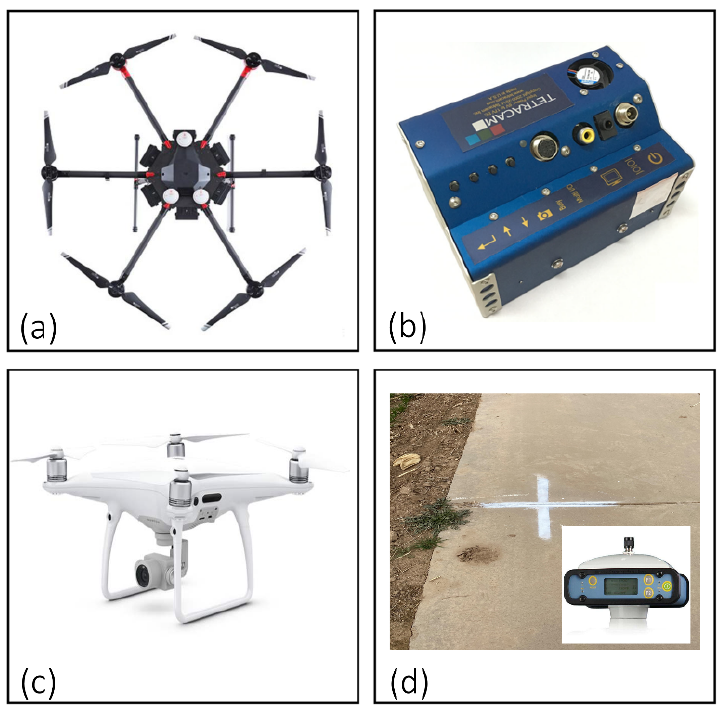
Figure 2. The UAV and cameras applied for data collection: ( a ) DJI M600 Pro UAV; ( b ) Mini MCA 6 Camera; ( c ) DJI Phantom 4 Pro V2.0; ( d ) ground control points.